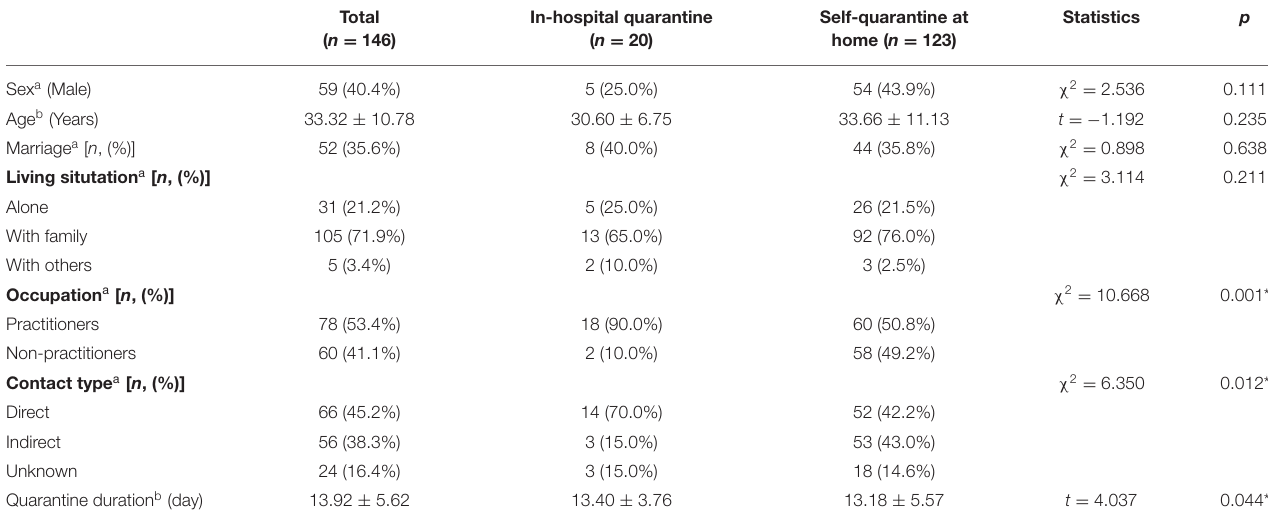
TABLE 1 | Sociodemographic characteristics of the respondents according to quarantine